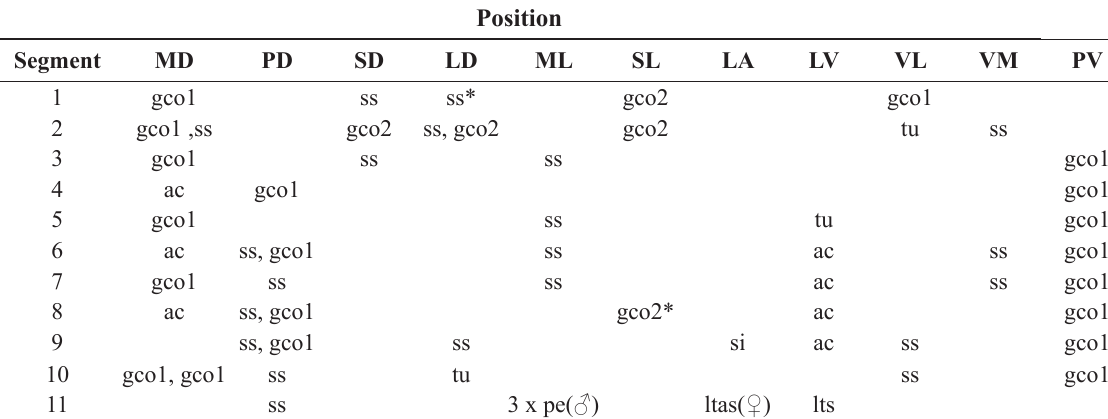
Table 7. Summary of nature and location of sensory spots, glandular cell outlets, tubes and spines arranged by series in Echinoderes hamiltonorum sp. nov. Abbreviations: LA = lateral accessory; LD = laterodorsal; LV = lateroventral; MD = middorsal; ML = midlateral; PD = paradorsal; PV = paraventral; SD = subdorsal; SL = sublateral; VL = ventrolateral; VM = ventromedial; ac = acicular spine; gco1/2 = glandular cell outlet type 1/2; ltas = lateral terminal accessory spine; lts = lateral terminal spine; pe = penile spines; si = sieve plate; ss = sensory spot; tu = tube; ( ♀) = female and ( ♂ ) = male conditions of sexually dimorphic characters; * = character not present in all